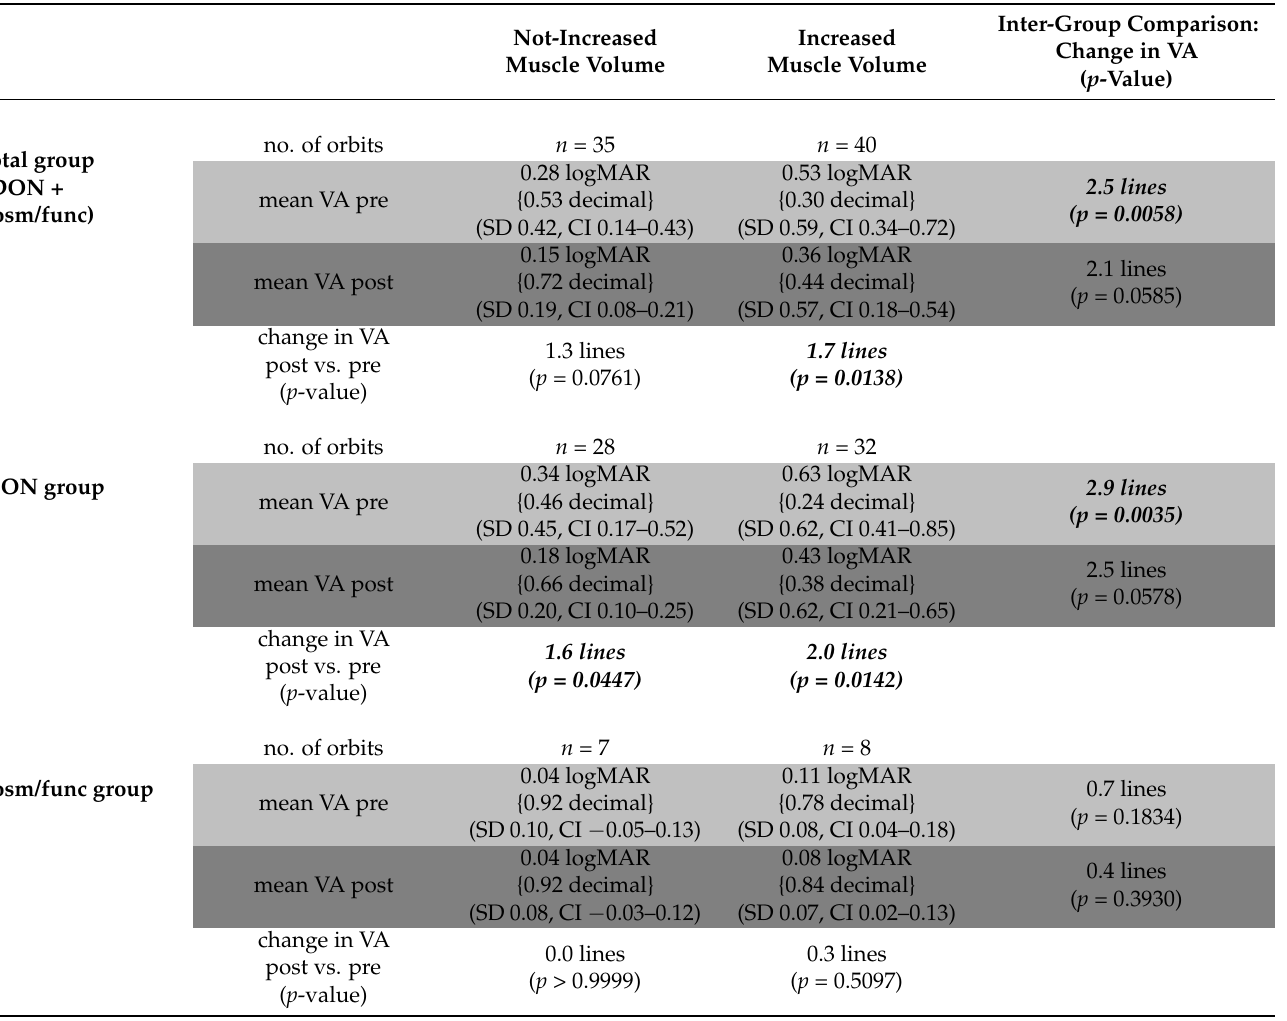
Table 2. Intra- and inter-group statistical analysis of pre- and postoperative visual acuity (analysis within and between “not-increased” and “increased” orbital muscle volume).